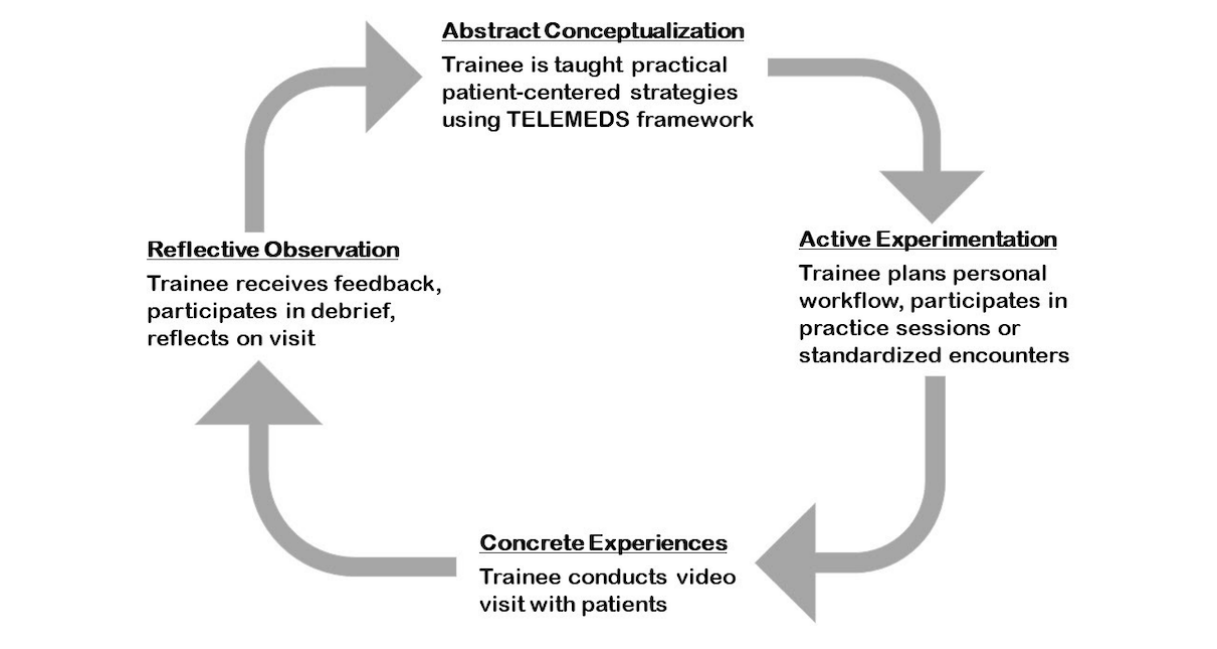
Figure 2. Kolb’s Experiential Learning Cycle [27]. Four stages to promote effective learning of patient-centered virtual visit